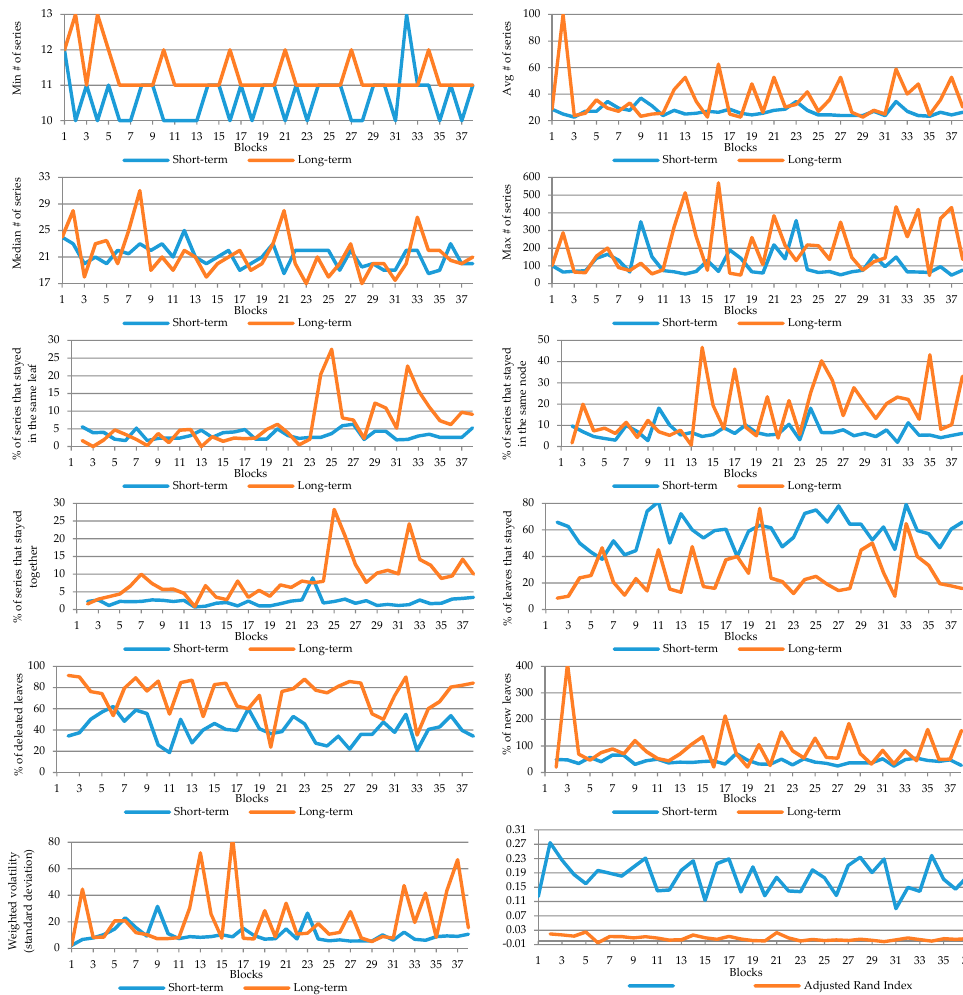
Figure A3. Detailed results for 𝑚𝑖𝑛𝑆𝑒𝑟𝑖𝑒𝑠 set at 1% and window length 𝑤 set at 14 days .